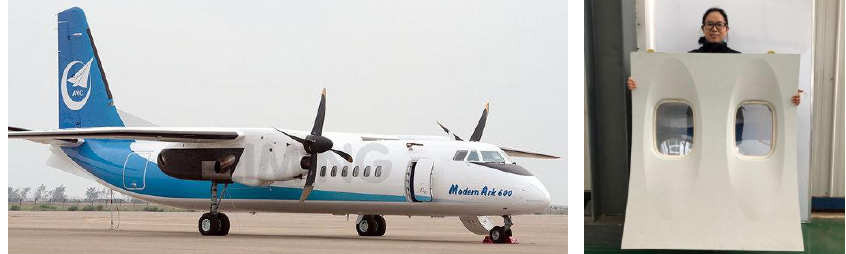
Figure 5. MA600 airplane and the composite side panel made of AGMP3600/honeycomb sandwich composites (Photos courtesy of Fangbo Ding, AVIC XAC, Commercial Aircraft Co., Ltd.).